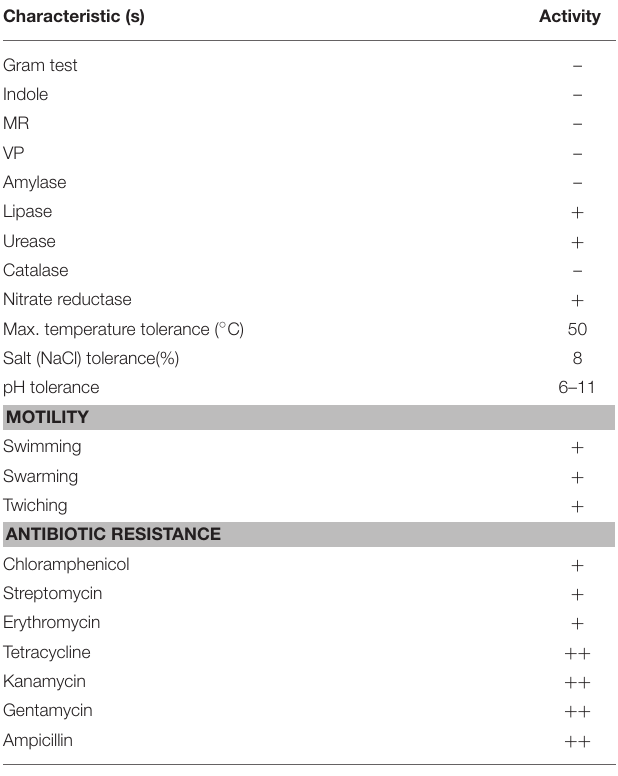
TABLE 1 | Biochemical characterization of isolate SBP-9. TABLE 2 | Plant growth promoting traits of strain SBP-9. Plant growth promoting